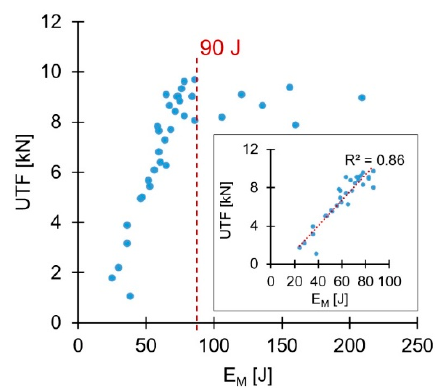
Figure 11. Correlation between mechanical performance and total energy input (E M ). In detail, the correlation for the energy efficient range (E M ≤ 90 J).